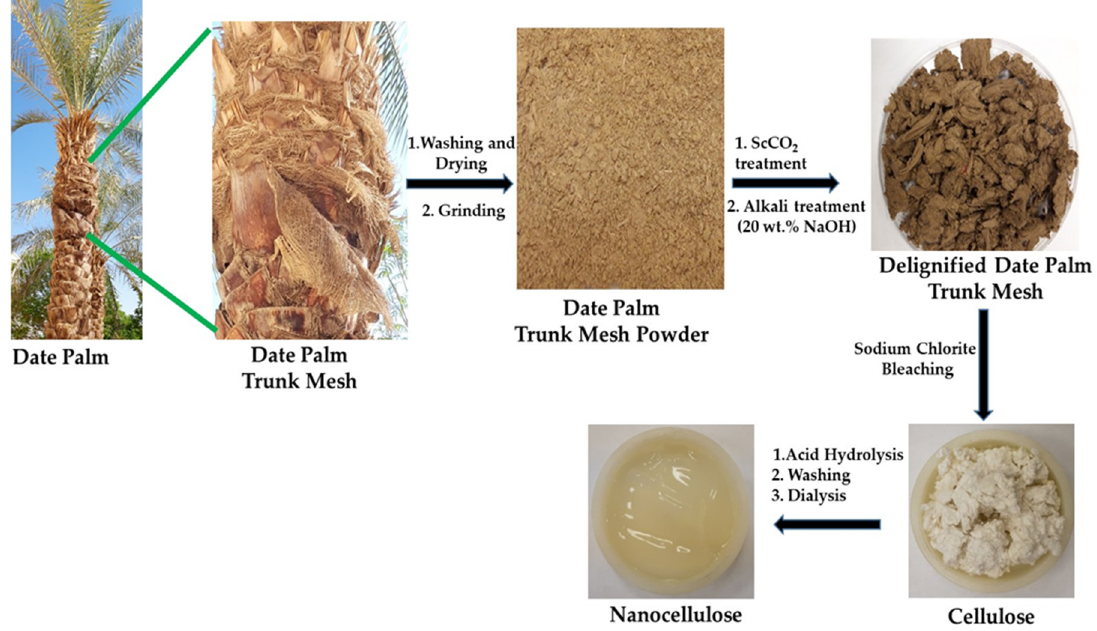
Figure 1. Photographs of DPTM fibers and products at various experimental stages.